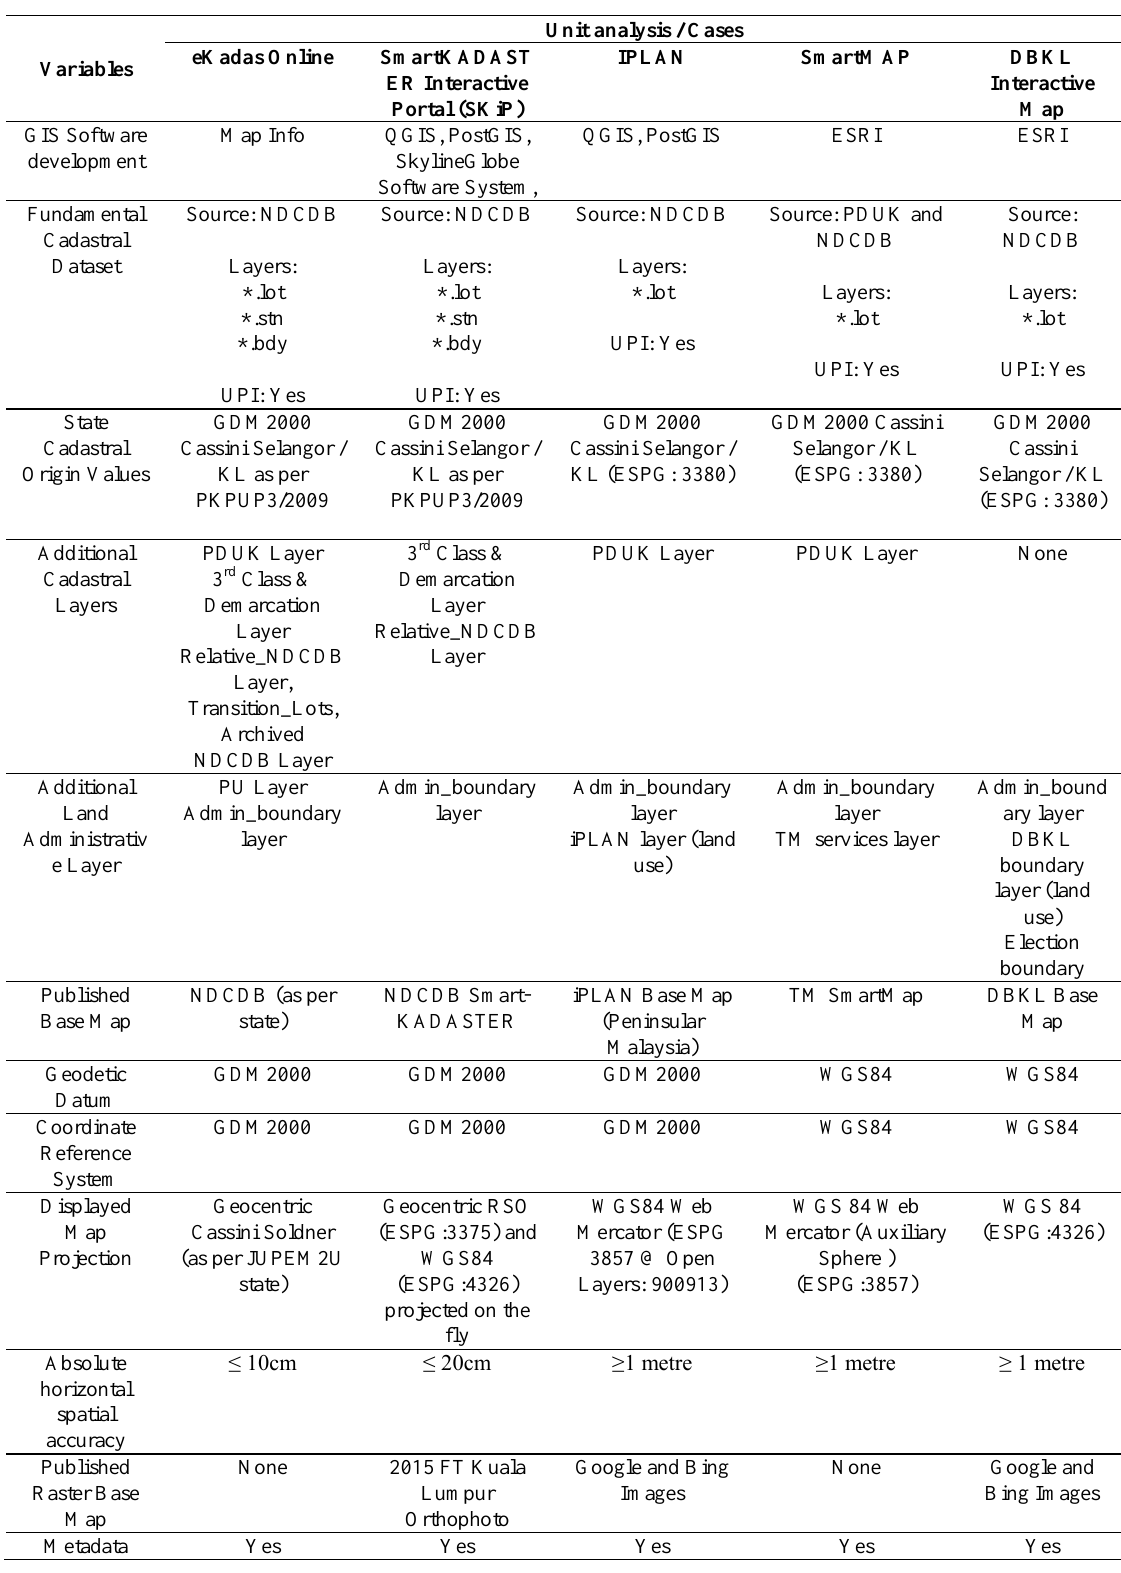
Table 2: Descriptive Meta-Matrix of the Multi-Case